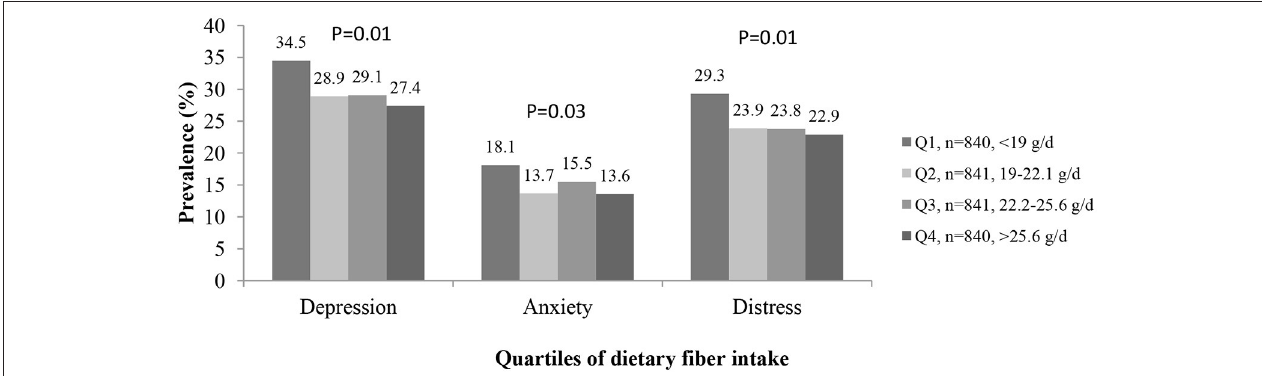
FIGURE 1 | The prevalence of depression, anxiety, and high psychological distress in study participants across different quartiles of energy-adjusted dietary fiber intake ( n = 3,362).